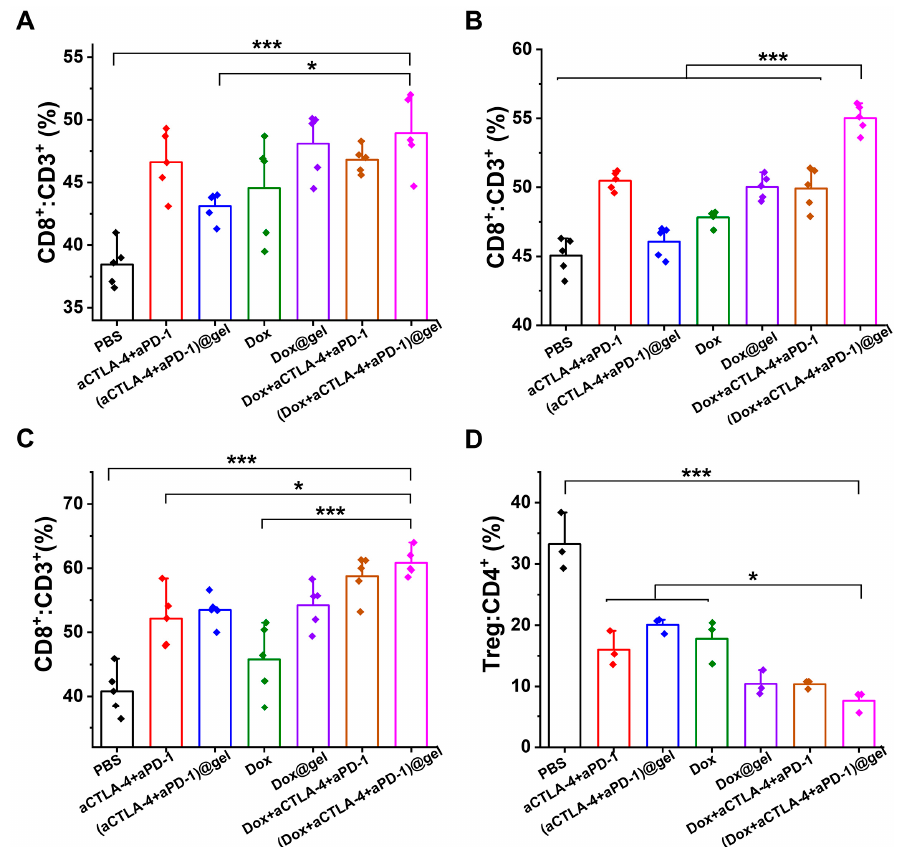
Figure 5. Immune cell analysis results of spleens, lymph nodes and tumors of the melanoma-bearing mice model after receiving various treatments, obtained by flow cytometry. ( A ) Ratio of CD8 + :CD3 + in spleen ( n = 5). ( B ) Ratio of CD8 + :CD3 + in lymph ( n = 5). ( C ) Ratio of CD8 + :CD3 + in the tumor ( n = 5). ( D ) Ratio of Treg:CD4 + in the tumor ( n = 3). (* p < 0.05 and *** p <